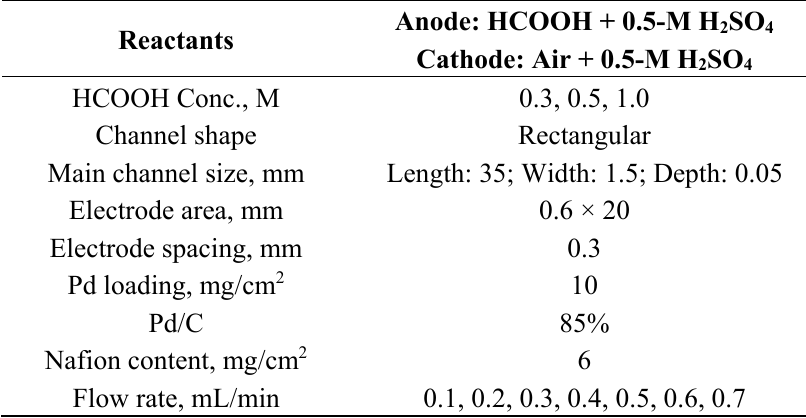
Table 1. Experimental conditions and anode